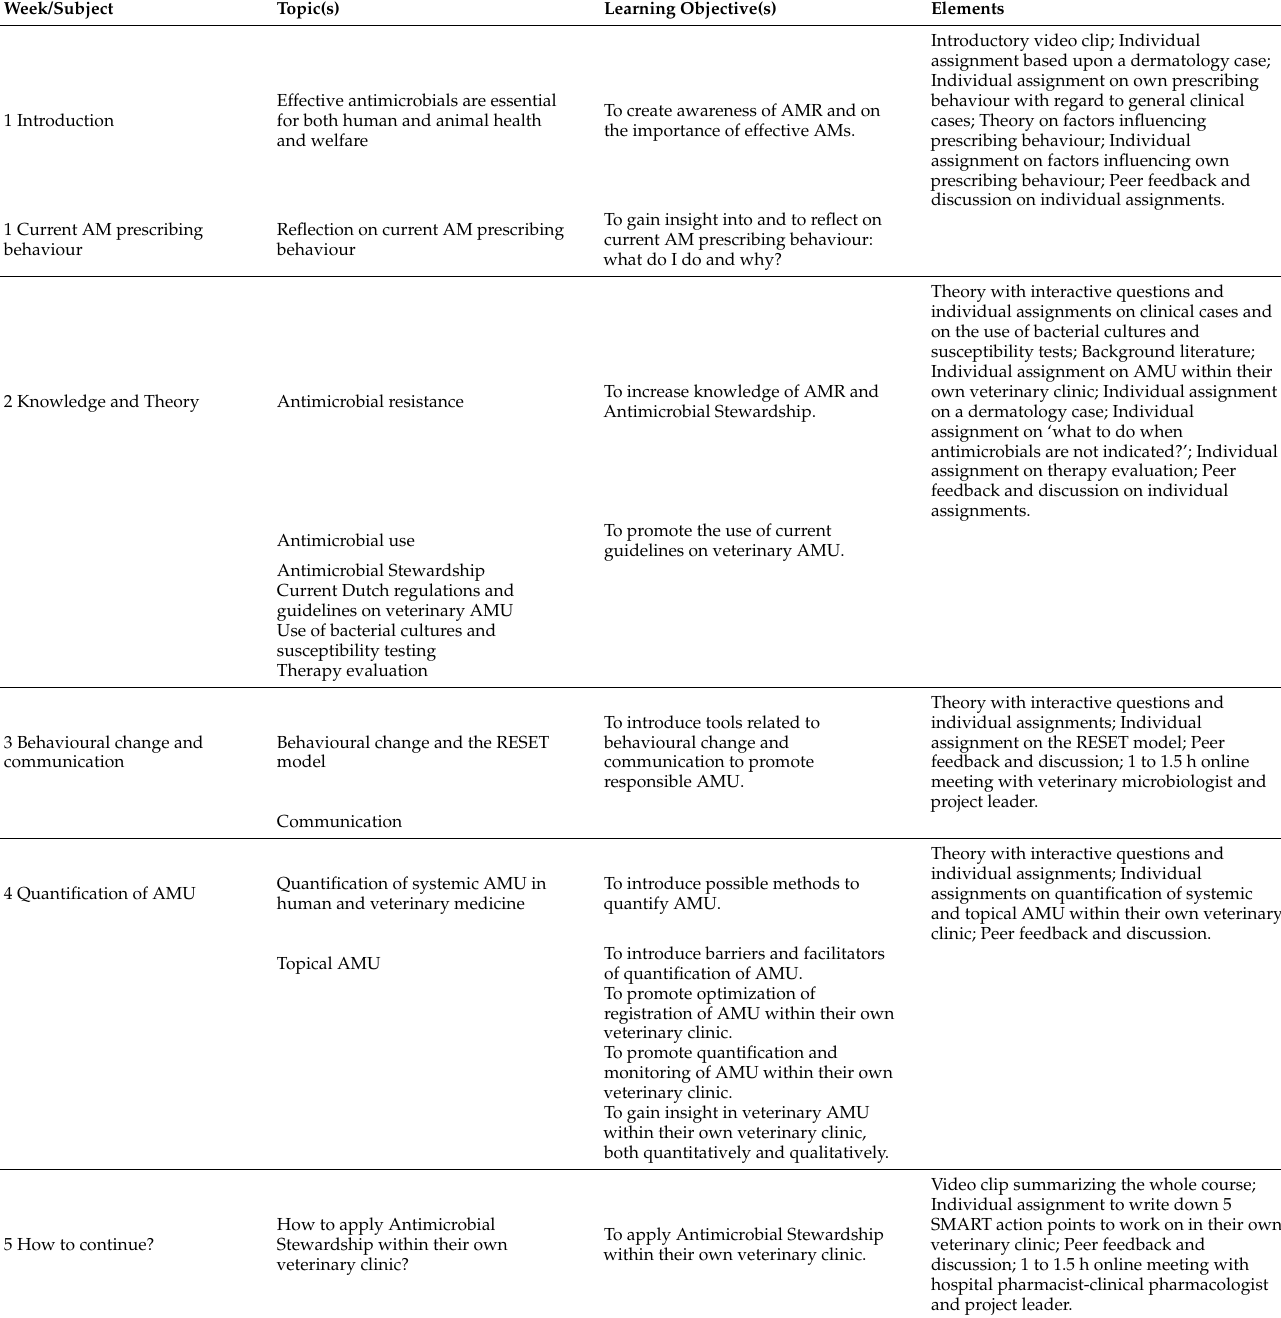
Table 1. Detailed description of the online course